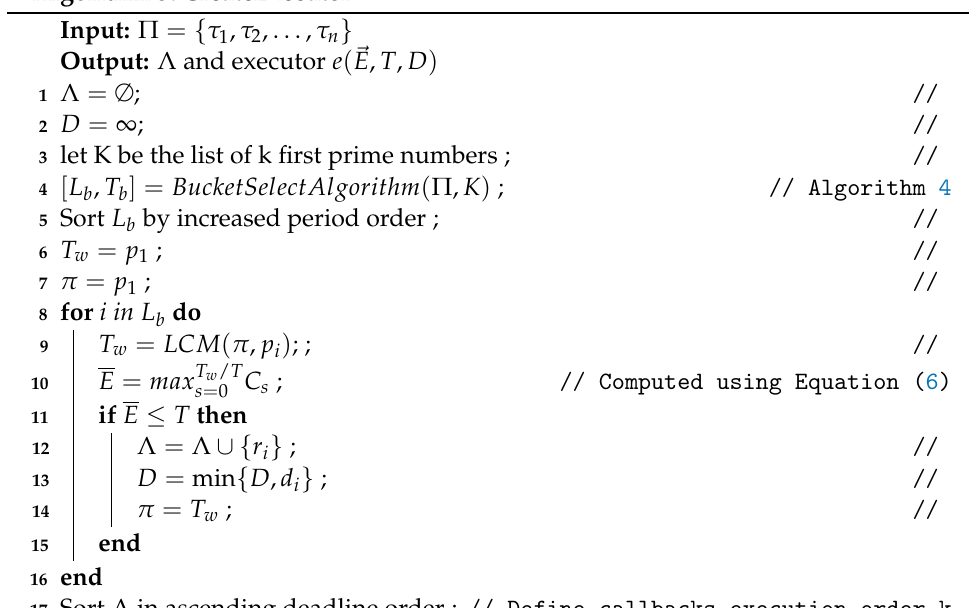
Algorithm 3: CreateExecutor